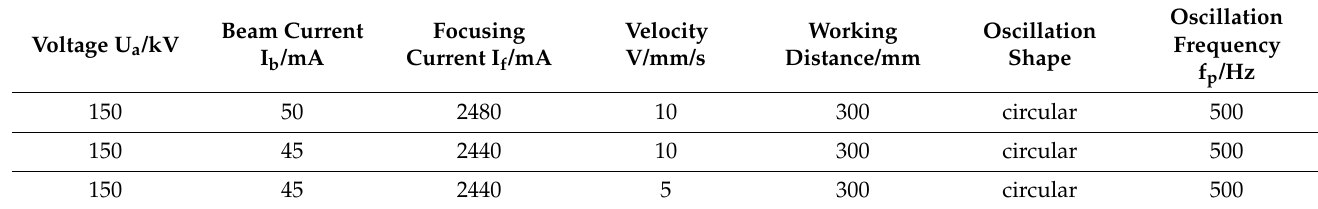
Table 2. Welding